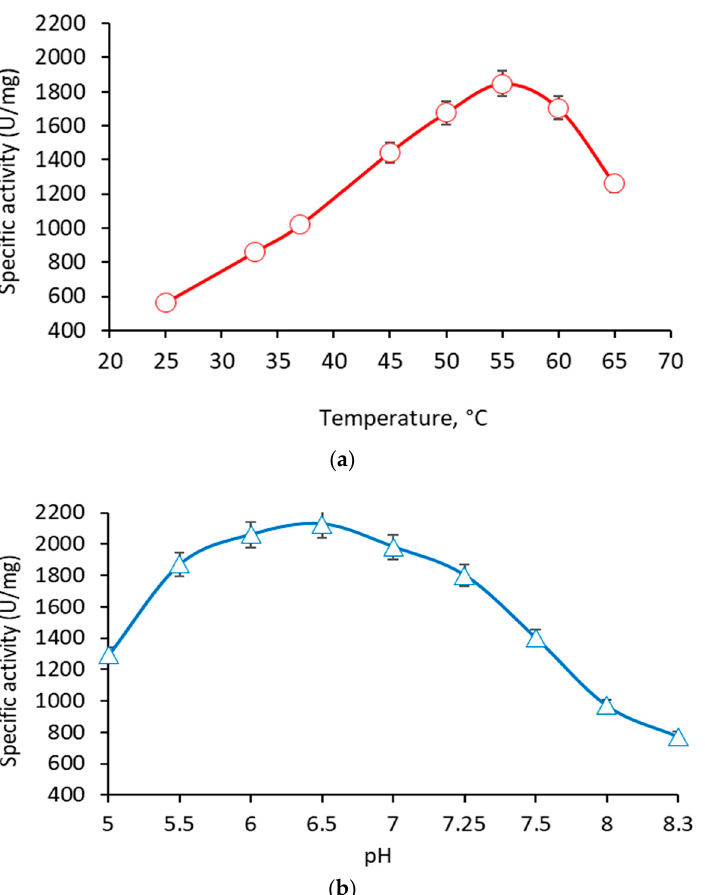
Figure 6. Influence of temperature ( a ) and pH ( b ) on the enzyme activity of the recombinant β - galactosidase from L. bulgaricus